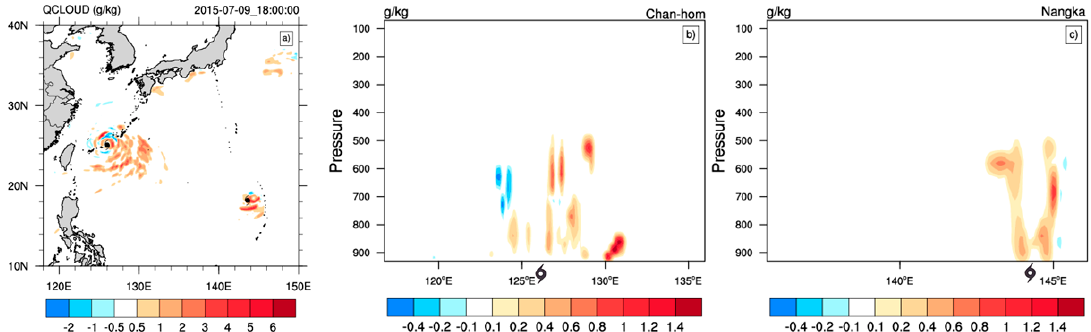
Atmosphere 2016 , 7 , x 17 of 4 Figure 16. ( a )The integrated cloud water mixing ratio di ff erence (g / kg), the west–east cross-sections Figure 16. ( a )The integrated cloud water mixing ratio difference (g/kg), the west–east cross-sections from the ALLSKY experiment, with black typhoon mark in the x axis for the longitude of Chan-hom of cloud water mixing ratio di ff erence along ( b ) 25.261 ◦ N and ( c ) 18.517 ◦ N at 1800 UTC on 9 July of cloud water mixing ratio difference along ( b ) 25.261° N and ( c ) 18.517° N at 1800 UTC on 9 July and Nangka. from the ALLSKY experiment, with black typhoon mark in the x -axis for the longitude of Chan-hom and Nangka.